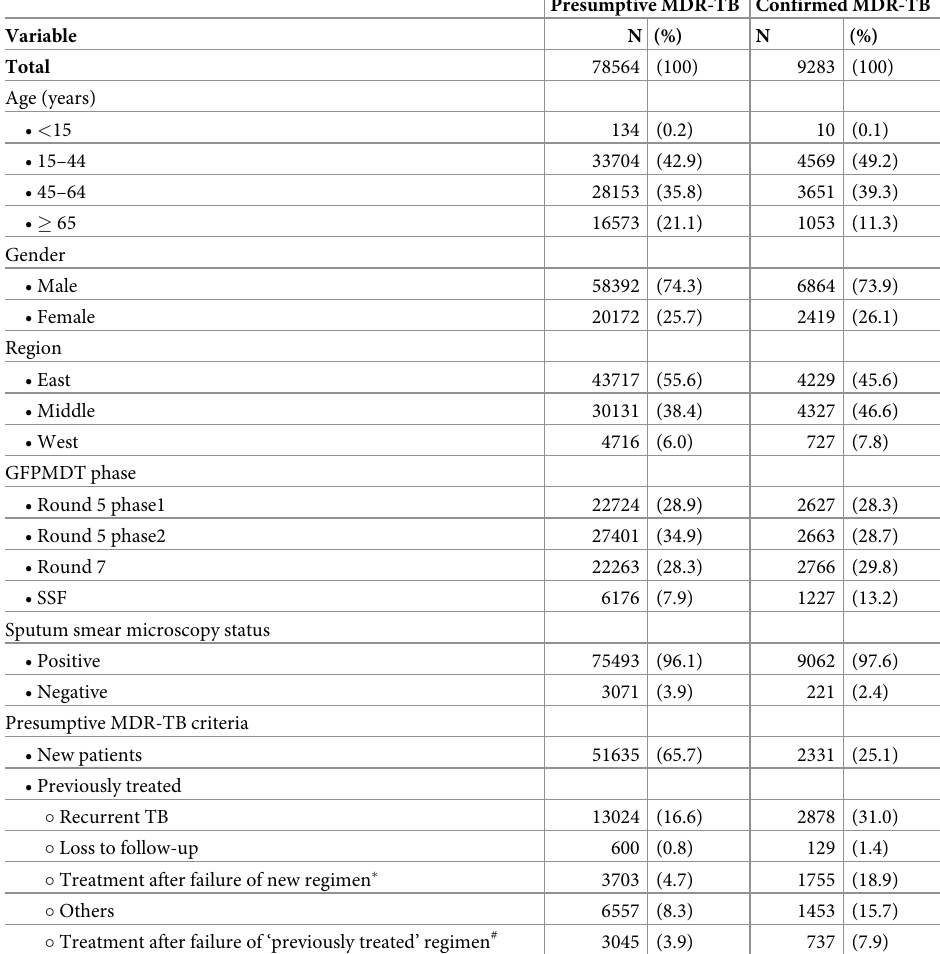
Table 2. Clinical and demographic profile of presumptive MDR-TB patients and confirmed MDR-TB patients under GFPMDT project in China, October 2006-June 2013 [N =